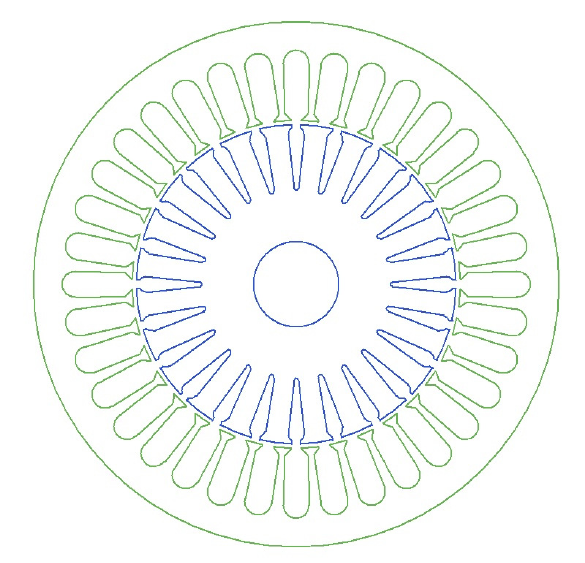
Figure 8. Stator and rotor in RMxprt.